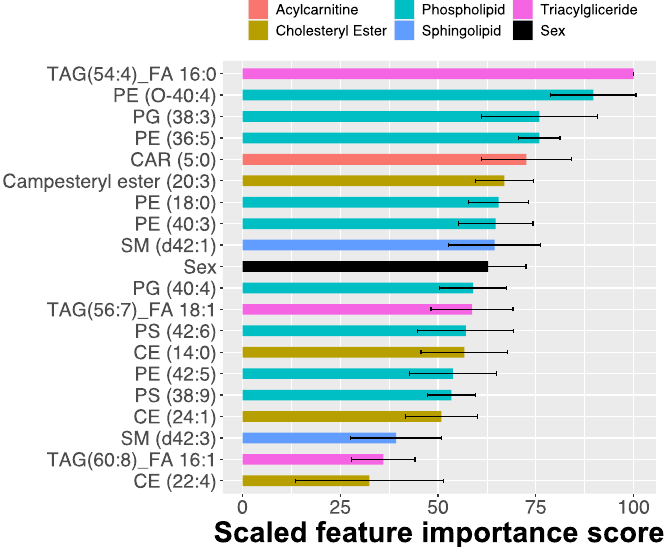
Figure 8. The most predictive blood lipid features identified by elastic-net-regularized logistic regression for CAD occurrence.